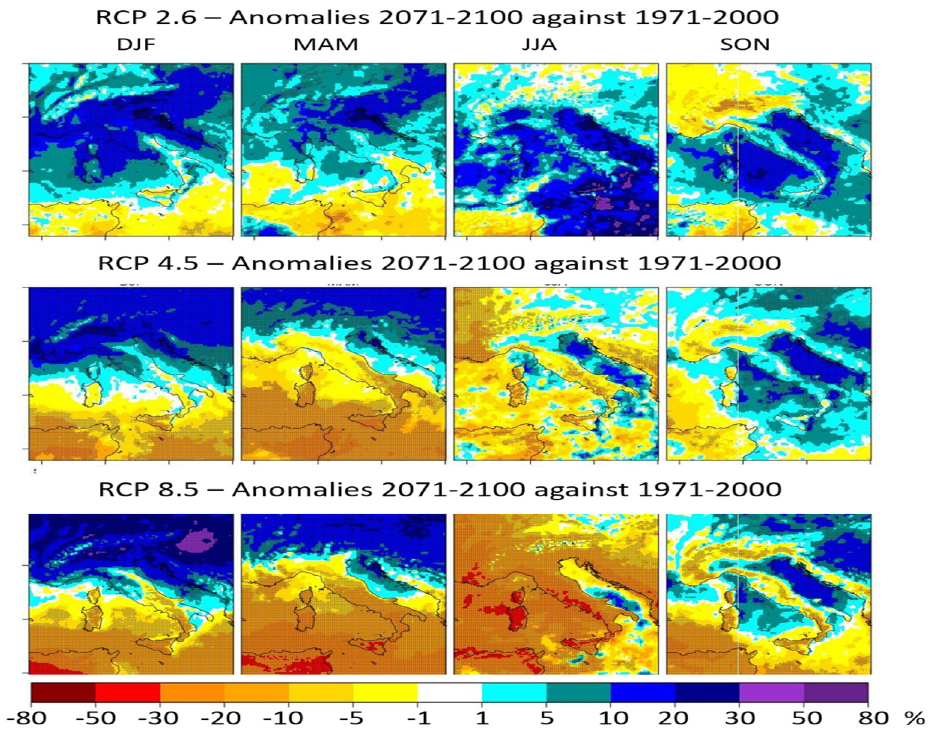
Figure 8. As Figure 6, but for anomalies expected by 2071–2100 against 1971–2000.